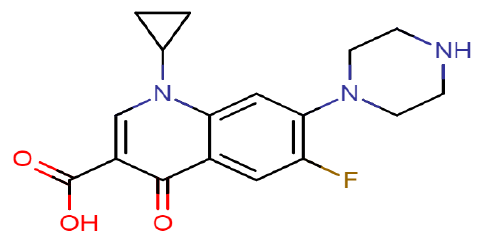
Figure 2. Chemical Structures of Ciprofloxacin